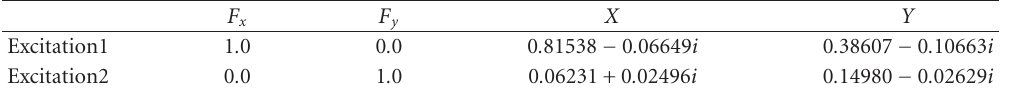
Table 6: Excitation forces ( ω 1 / Ω = ω 2 / Ω = 0 . 3, W/c =